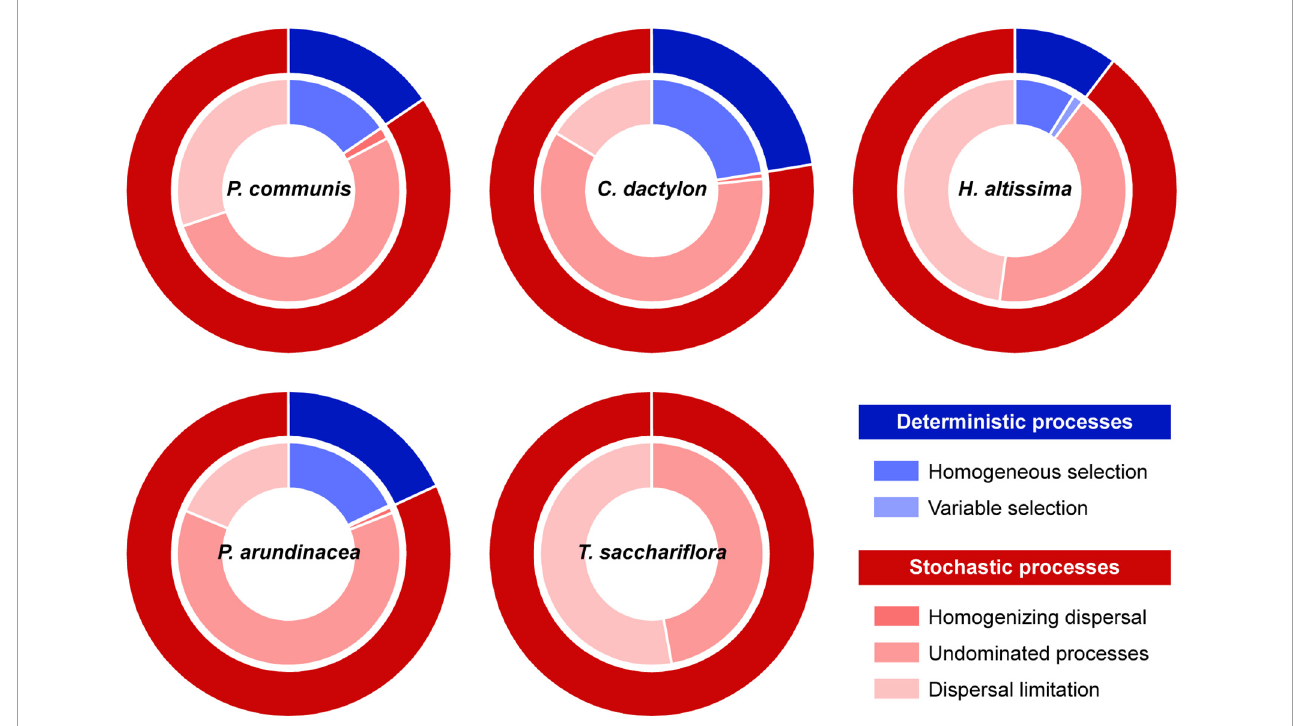
FIGURE3 Assembly processes of rhizosphere fungal communities from different plant species. The assembly processes were identified based on two indices of β -nearest taxon index ( β NTI) and raup-crick index (RCI). Variable and homogeneous selection belong to deterministic processes; dispersal limitation, homogenizing dispersal, and undominated processes are affiliated to stochastic